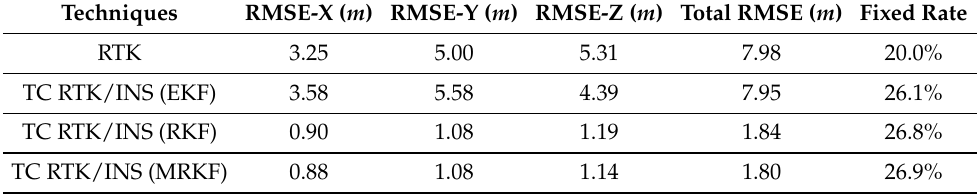
Table 7. The positioning performance comparison between four techniques (Odaiba).